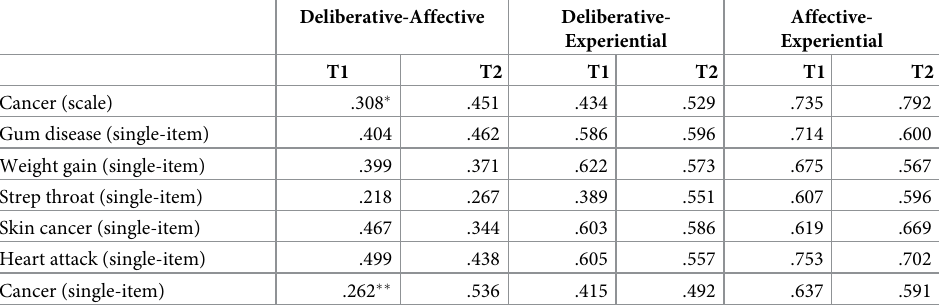
Table 1. Pilot study: Correlations among deliberative, affective, and experiential risk perceptions across threats (T1 and T2).